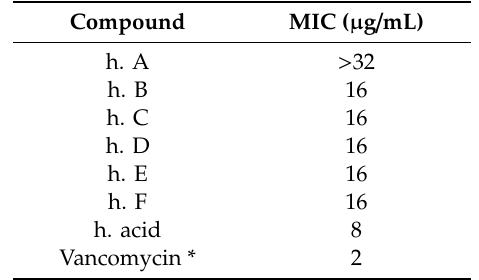
Figure 6. Structures of chromene and chromane stilbenoids Starks et al. (2014) [70]. Table 9. Antibacterial activity of hymenocardichrom-ene/anes against MRSA-108 S. aureus from Starks et al. (2014) [70].